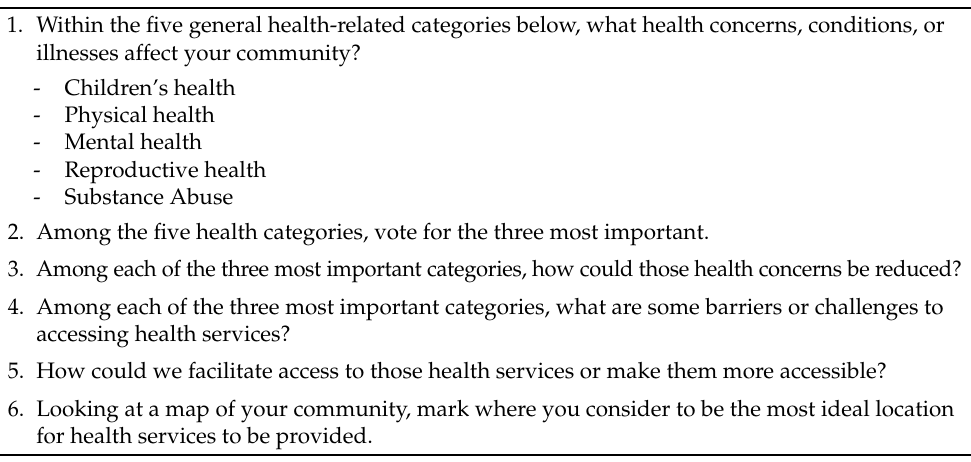
Table 1. In-home meeting interview guide.